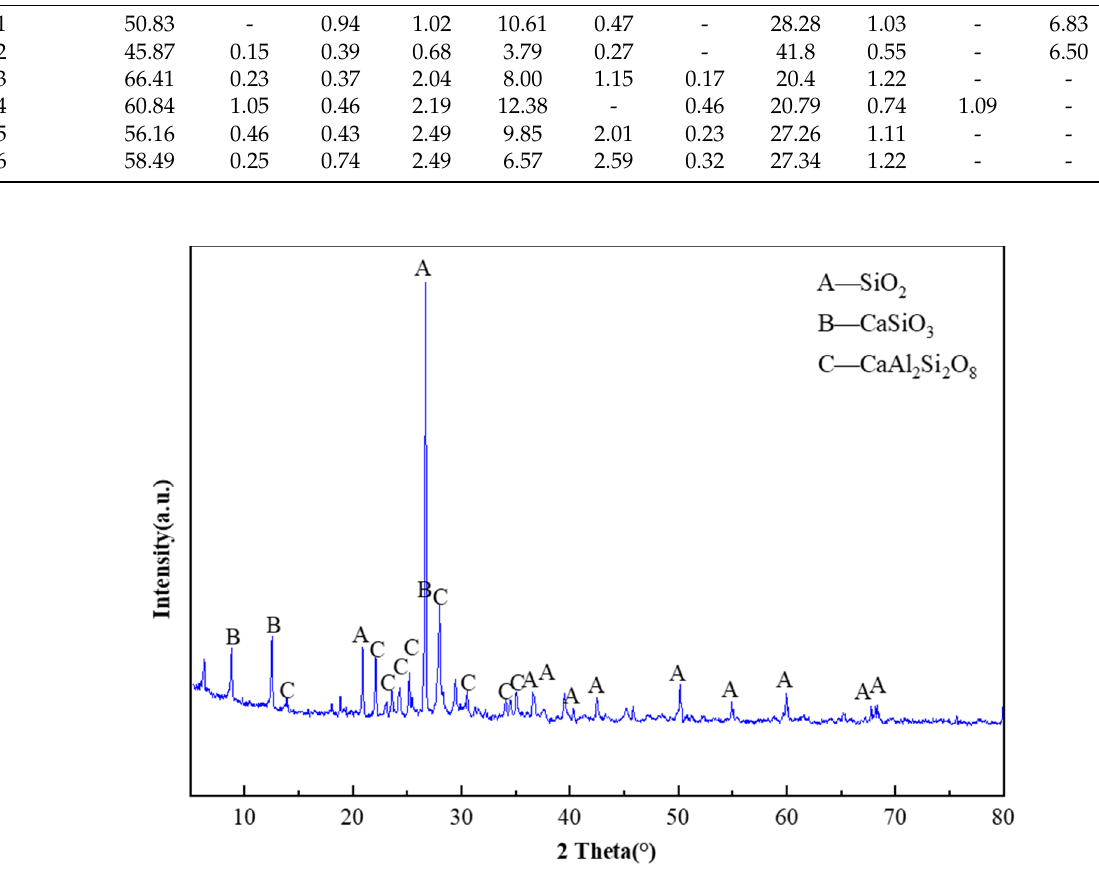
Figure 11. XRD microstructure analysis results.